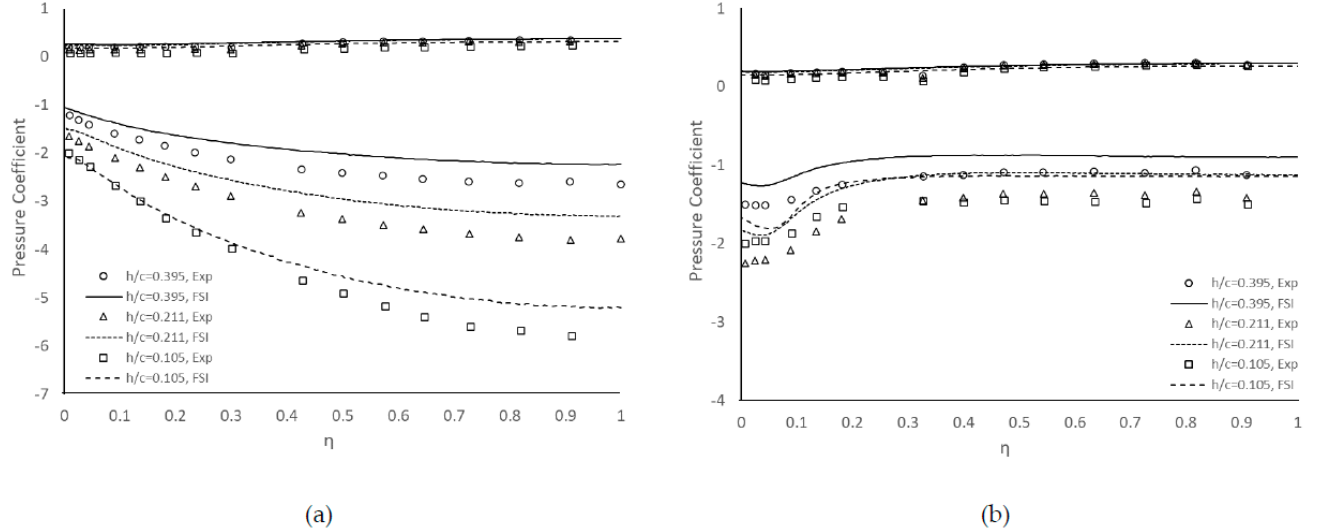
Figure 11. Spanwise surface pressure at various heights: ( a ) main element, ( b ) flap.